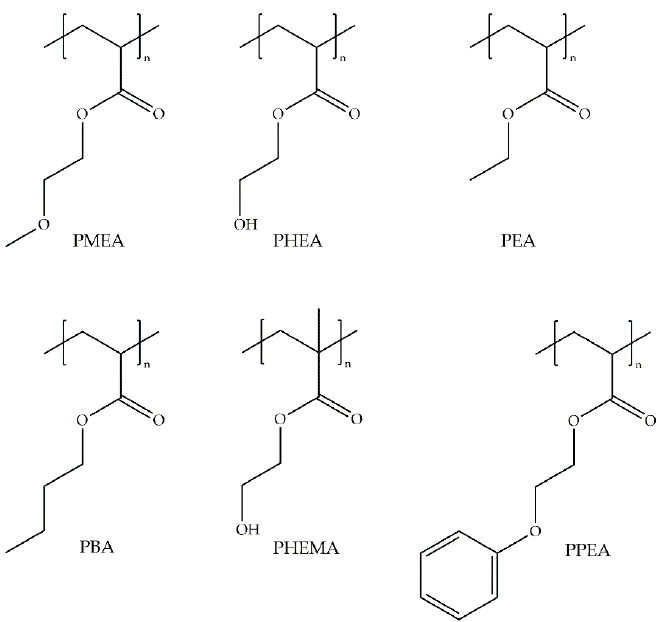
Figure 21. Molecular structure of poly(meth)acrylates.